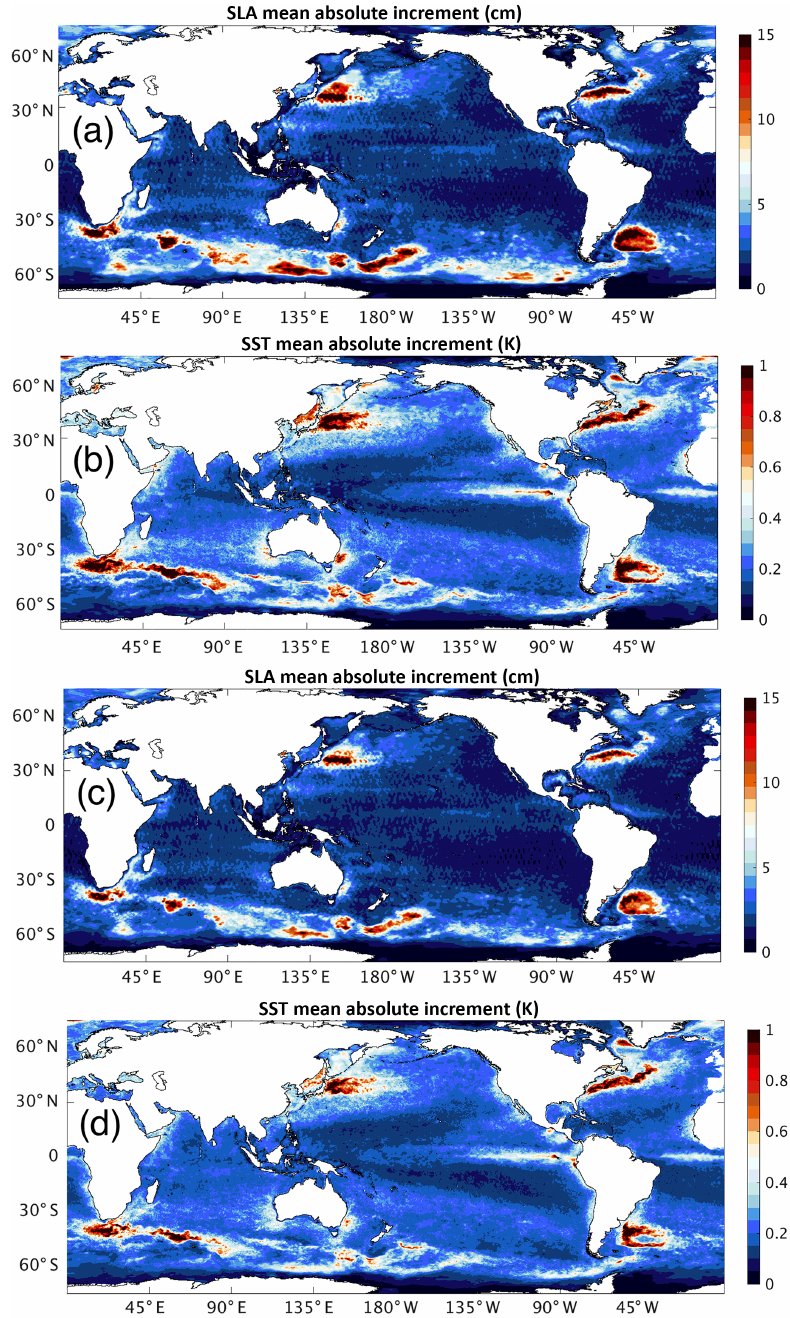
Figure 5. Mean absolute increments for sea-level anomaly (SLA) and sea surface temperature (SST) for the 1-day (a, b) and 3-day system (c, d)